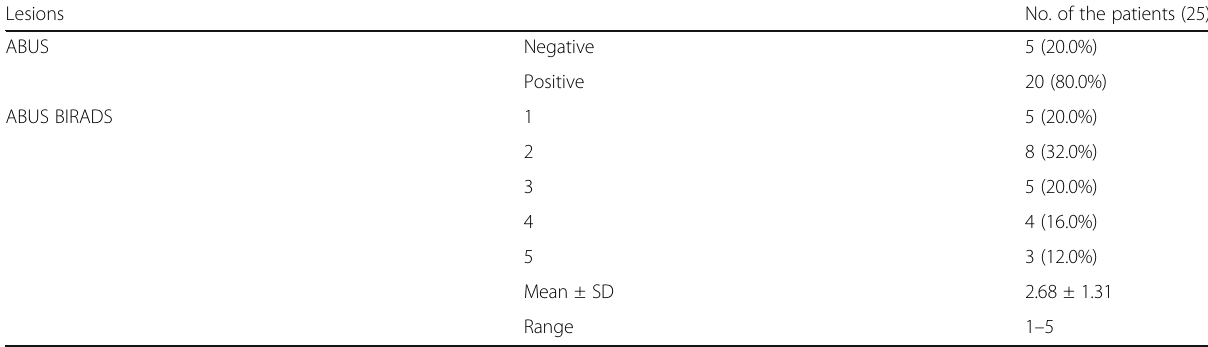
Table 4 Detected lesions by ABUS and correlated BIRADS